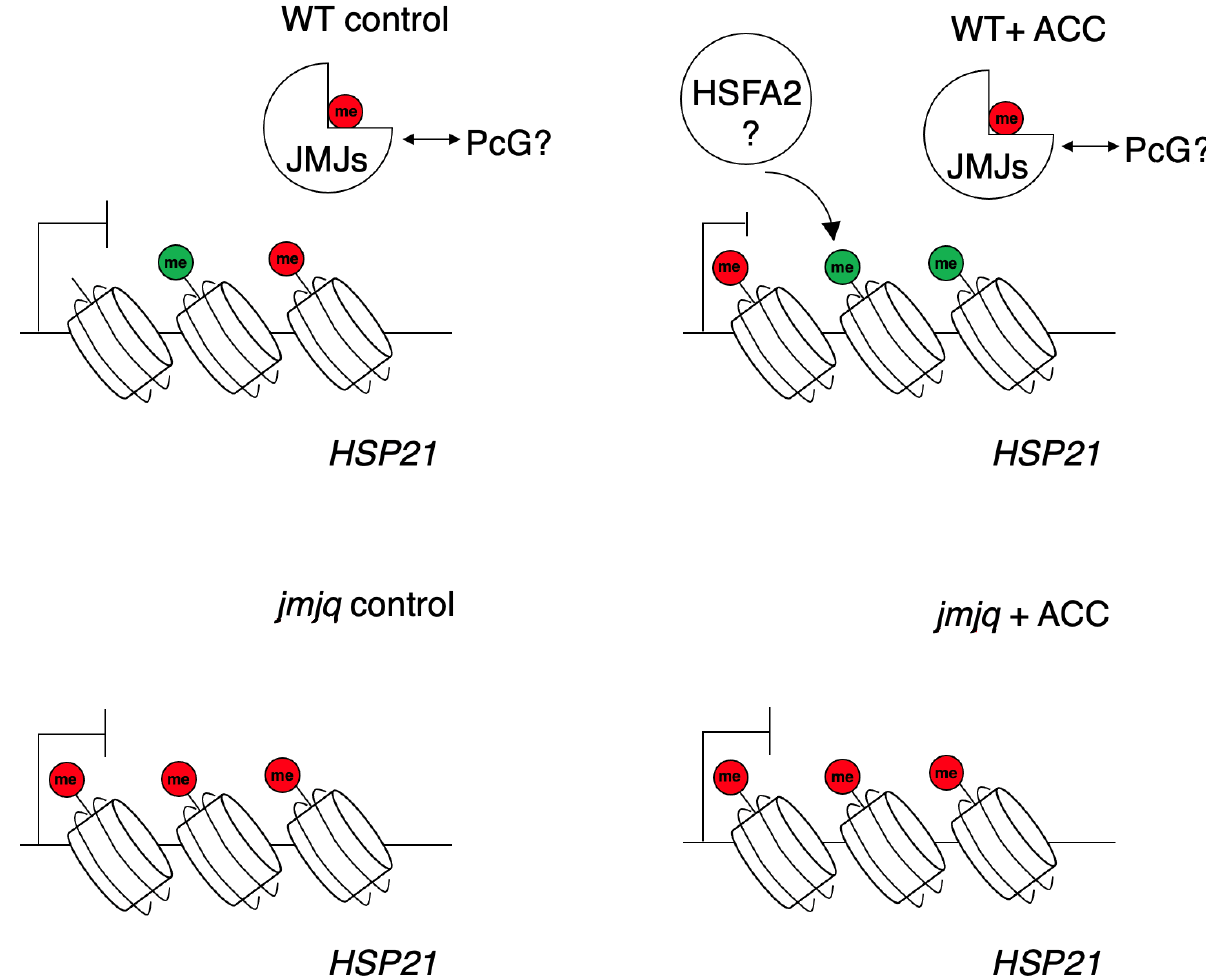
Figure 5. The current model of JMJ-mediated balance between H3K27me3 and H3K4me3 at the HSP21 locus. Three red and green circles represent H3K27me3 and H3K4me3, respectively. JMJs are required to sustain H3K4me3 methylation. In jmjq mutants, higher H3K27me3 accumulation inhibits proper accumulation of H3K4me3 at the HSP21 locus.